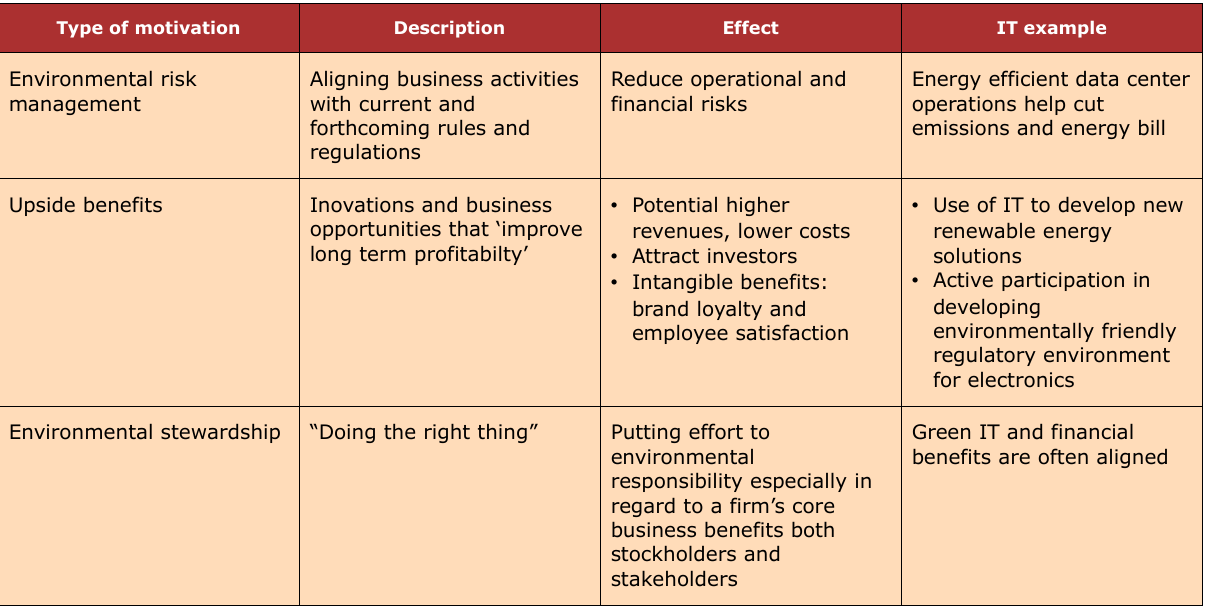
Table 1. Motivations behind environmental responsibility (Tenhunen, 2011: page